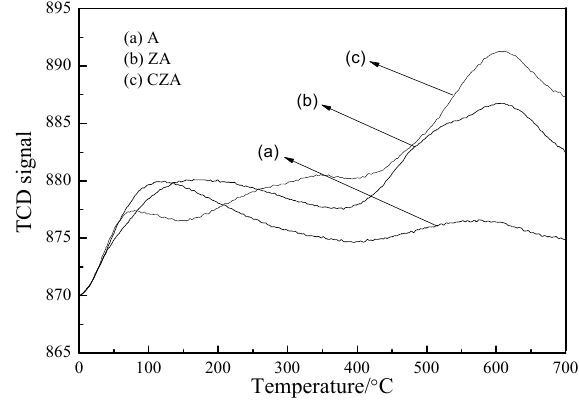
Figure 1. NH 3 -TPD curves of the catalysts.